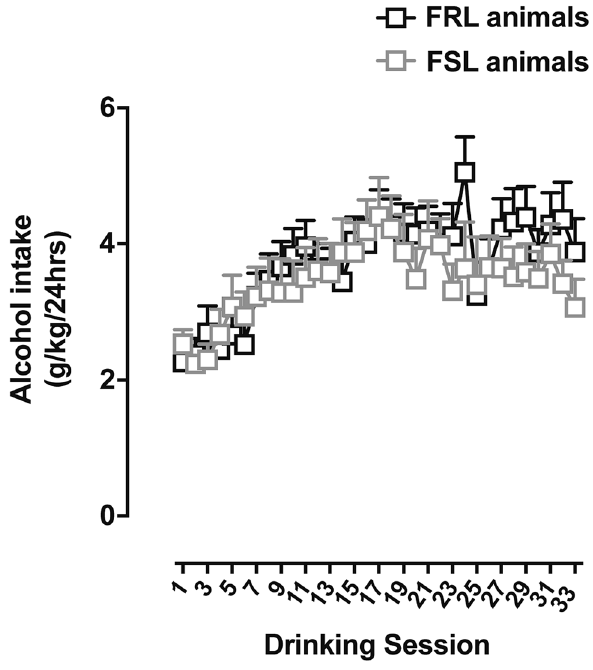
Figure 3. Alcohol intake levels in FSL and FRL animals. Animals had voluntary access to alcohol for a total of n = 33 IA20E alcohol sessions prior to the OSU experiment. Both FSL and control-FRL animals escalated significantly their alcohol intake as the result of time/drinking session. However, there was no significant difference in alcohol intake between FSL and controls at any given session (n = 10 animals per group; n = 1 outlier alcohol session). Graph data are presented as mean ± SEM and were analyzed by a mixed-effects model.